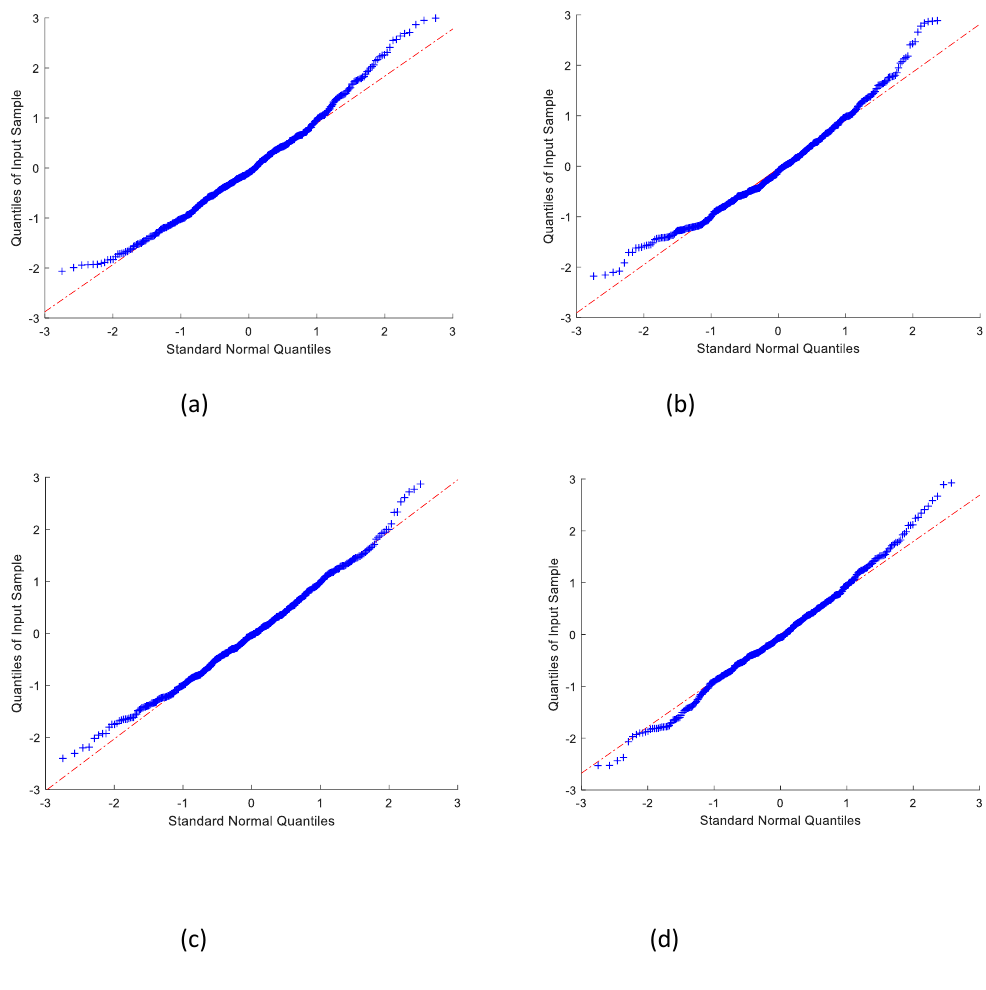
Figure 1. QQ plot of estimated coefficient on X 2